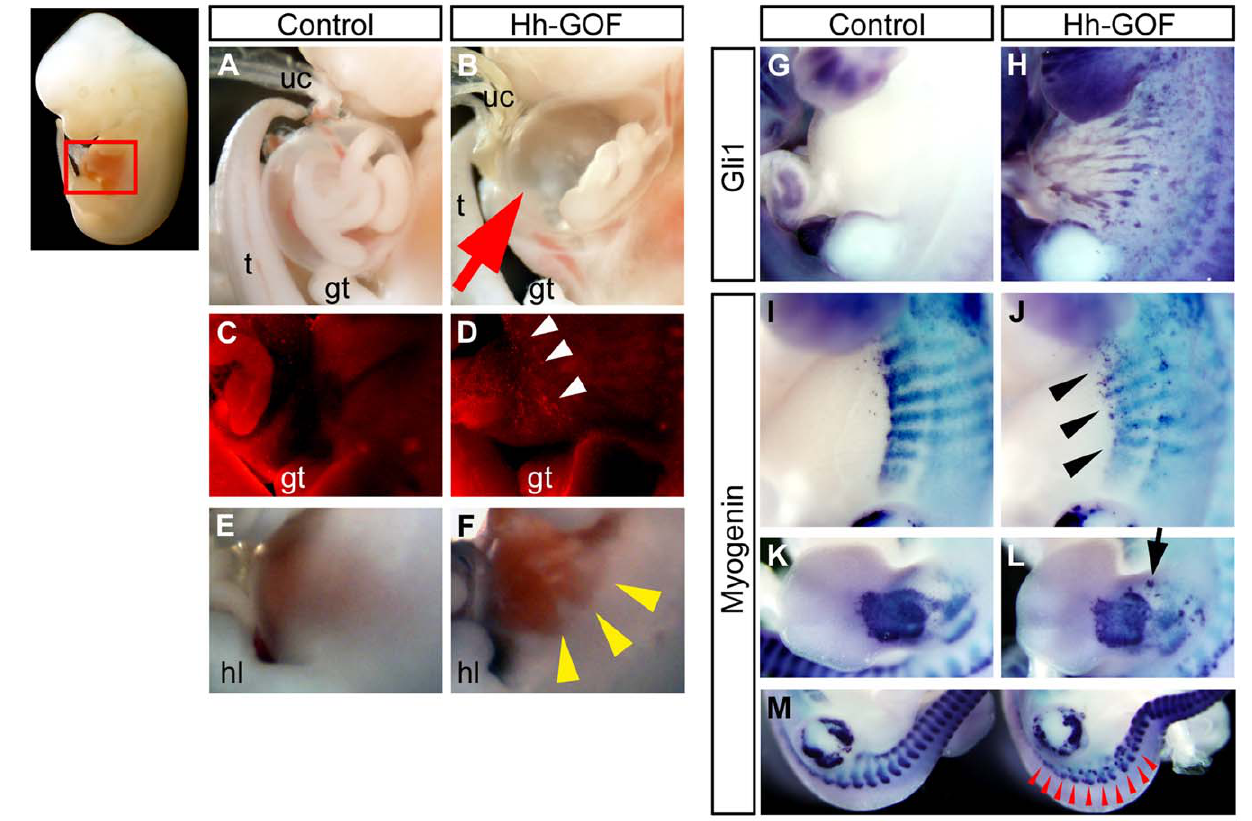
Figure 6. Formation of embryonic abdominal muscles and herniation of the visceral organs are affected by Hh signal activation. The CAGGS-CreER TM ; R26-SmoM2 (Hh-GOF) mutant embryos showed a moderate degree of herniation into the sac (peritoneal membrane) of physiological umbilical hernia compared with control embryos ( A , B ; red arrow). Hh-GOF mutants also exhibited more prominent cell death compared with controls as determined by acridine orange staining ( C , D ; white arrowheads). In addition, the lateral embryonic trunk was malformed in mutants ( E , F ; yellow arrowheads). Expression analysis of Gli1 confirmed the ectopic induction of Hh signaling in the ventral body wall ( G , H ). Myogenin expression was weaker ( J ; black arrowheads) and ectopically located ( L ; black arrow) in Hh-GOF mutants ( I–M ). Red arrowheads indicate affected muscle precursors after Hh activation.